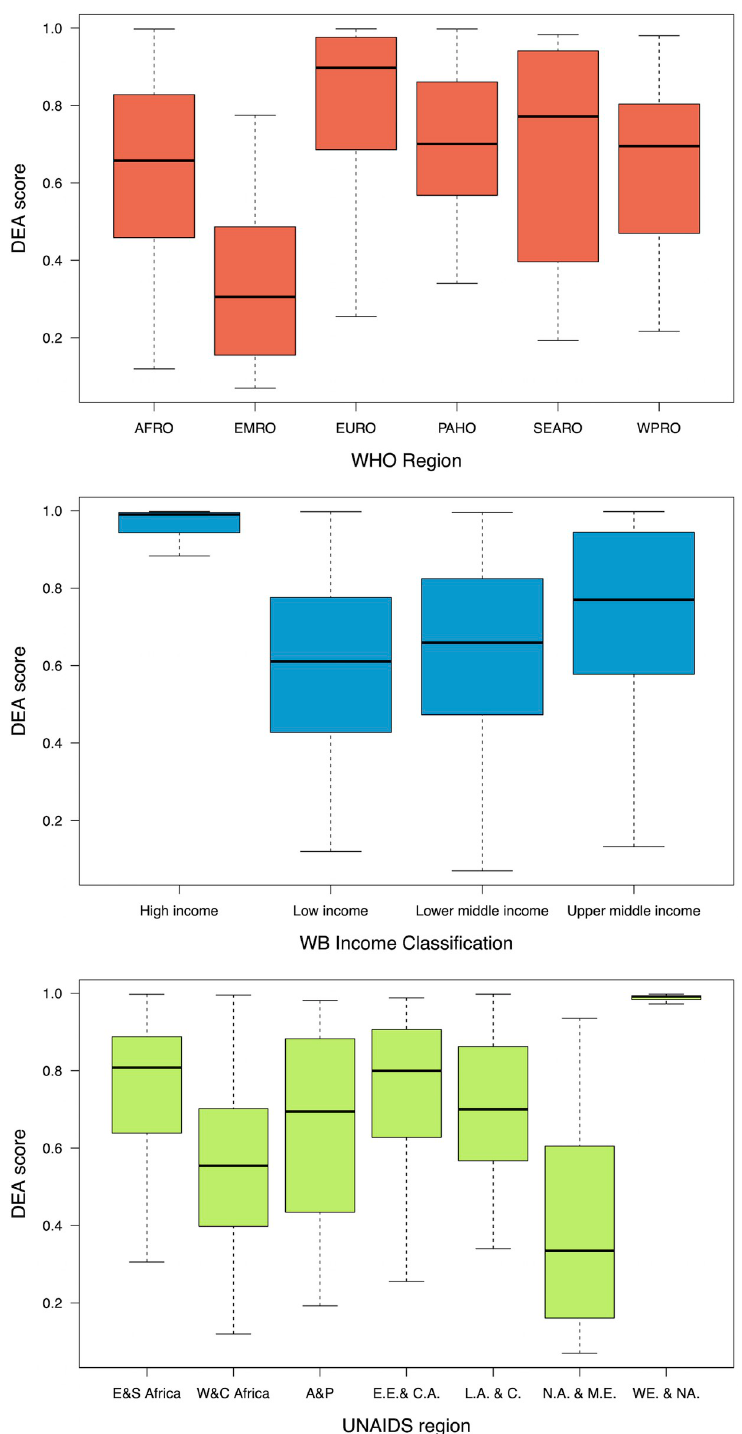
Fig 4. Bias-corrected efficiency scores from the base model by year, WB income group and WHO region. Notes : Robust reciprocal of bias-corrected efficiency scores were used. Horizontal lines represent median values, boxes show the IQR, whiskers show data points within 1.5x|IQR|. E&S stands for Easter and Southern, W&C for Western and Central, A&P is Asia and the Pacific, E.E. & C.A. is Eastern Europe and Central Asia, L.A.&C.A. Latin America and the Caribbean, N.A.&M.E. is North Africa and Middle East, and WE.&NA. is Western and Central Europe and North America.